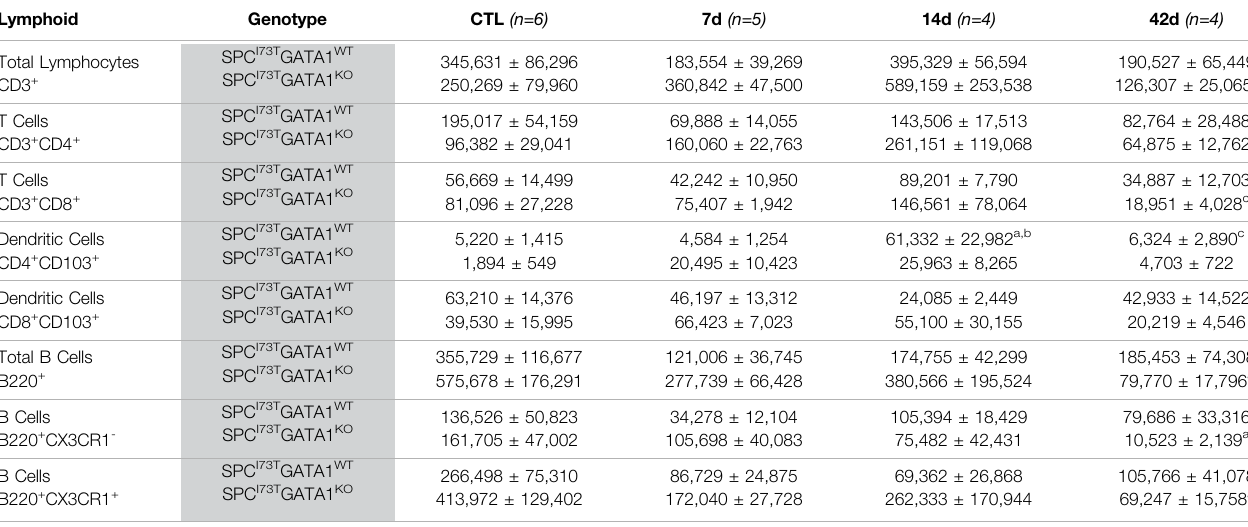
TABLE 3 | Lymphoid populations (absolute counts) in the lung of SP-C I73T GATA1 WT and SP-C I73T GATA1 KO mice. Lymphoid